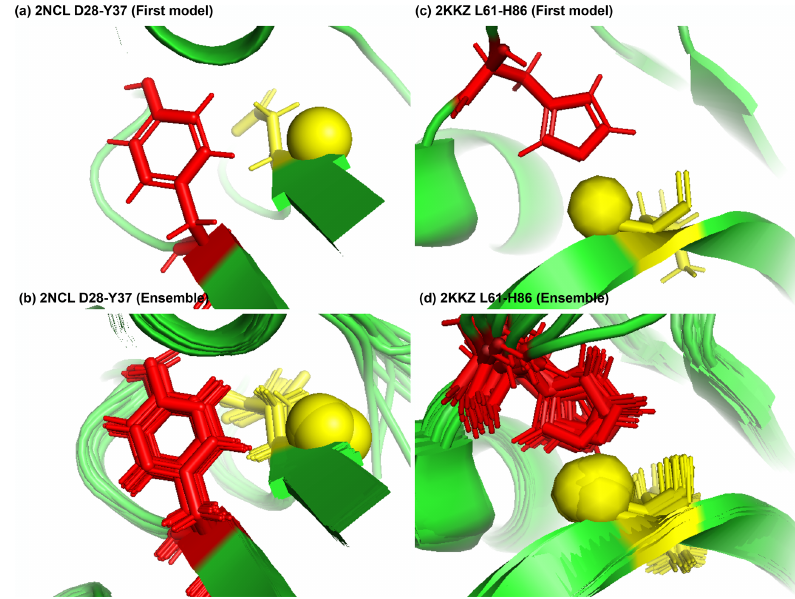
Figure 8. Examples of amide protons with extreme downfield shifts. (a, b) PDB:2NCL. The D28 amide proton is near the plane of Y37 aro- matic ring ( Z = 5.21, δ ASP = 11.387ppm, d = 5.62Å, θ = 72.0 ◦ , δ ASP = 8.299ppm, σ ASP = 0.588ppm). (c, d) PDB:2KKZ. The L61 amide proton forms a hydrogen bond with the sidechain nitrogen of H86 ( Z = 6.66, δ LEU = 12.56ppm, d = 3.22Å, θ = 69.7 ◦ , δ LEU = 8.217ppm, σ LEU = 0.735ppm). The amide proton is represented as a yellow sphere, and the aromatic sidechain is shown in red.